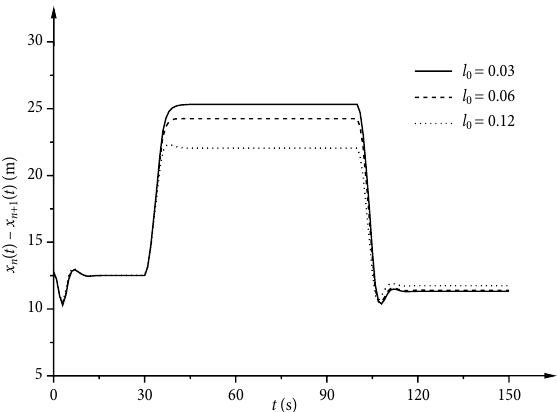
Fig. 6. A comparison between the follower’s sensitivity to the speed difference between the two vehicles and that to the leader’s acceleration, based on the settings in Ex.